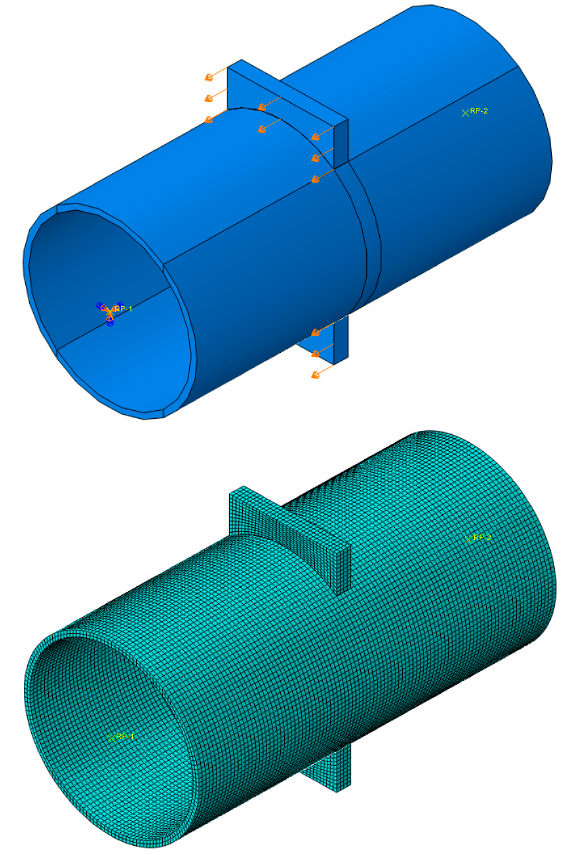
Figure 5. Detail of the loaded part of the connection ( top ) and of the mesh ( bo tt om